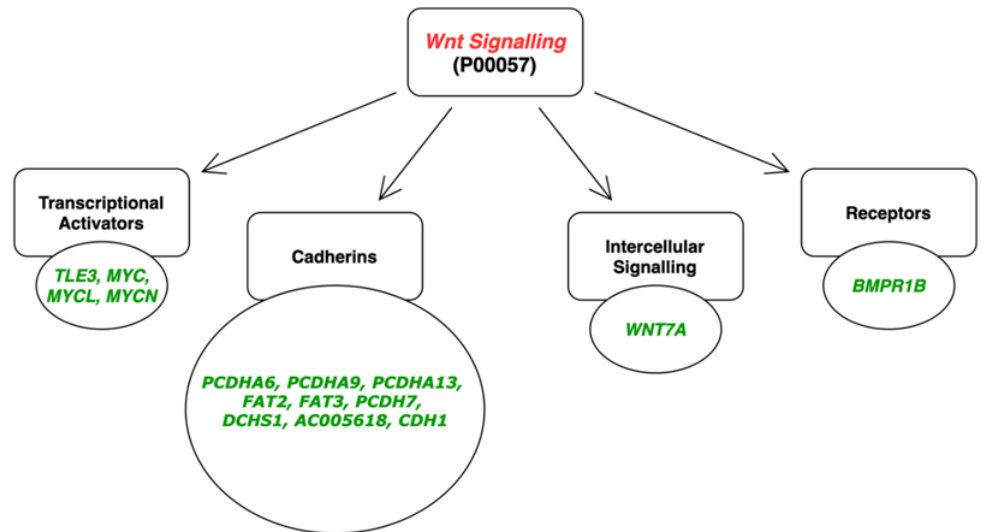
Figure 9. Major components of the Wnt signalling pathway upregulated by high density neural progenitor cell culture. Pathway analysis completed with PANTHER. GO: